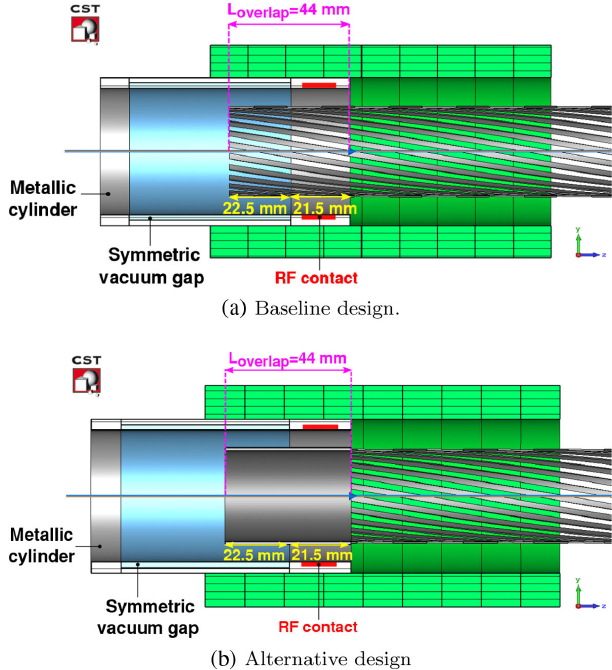
FIG. 9. Optimized models of the helical beam screen with a ¼ 44 mm. In a baseline symmetric vacuum gap and L overlap design, the screen conductors have ungraded lengths [Fig. 9(a)], whereas in an alternative design all screen conductors are con- nected in the overlap region [Fig.